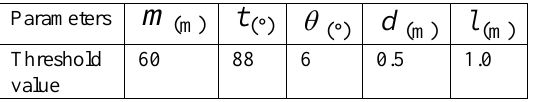
Table 1. Input five shared parameters of the two filters in the